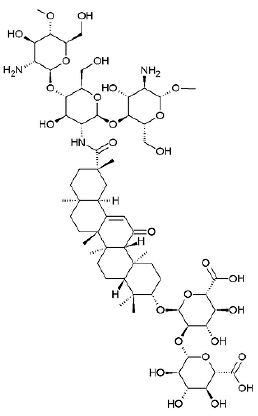
Figure 5. Glycyrrhizin conjugated chitosan. Table 3. Glycyrrhizin/glycyrrhetinic acid chitosan nanoparticles for the treatment of HCC and liver-targeting: the therapeutic/theranostic effect and cell cultures used in the study are reported for each reference.